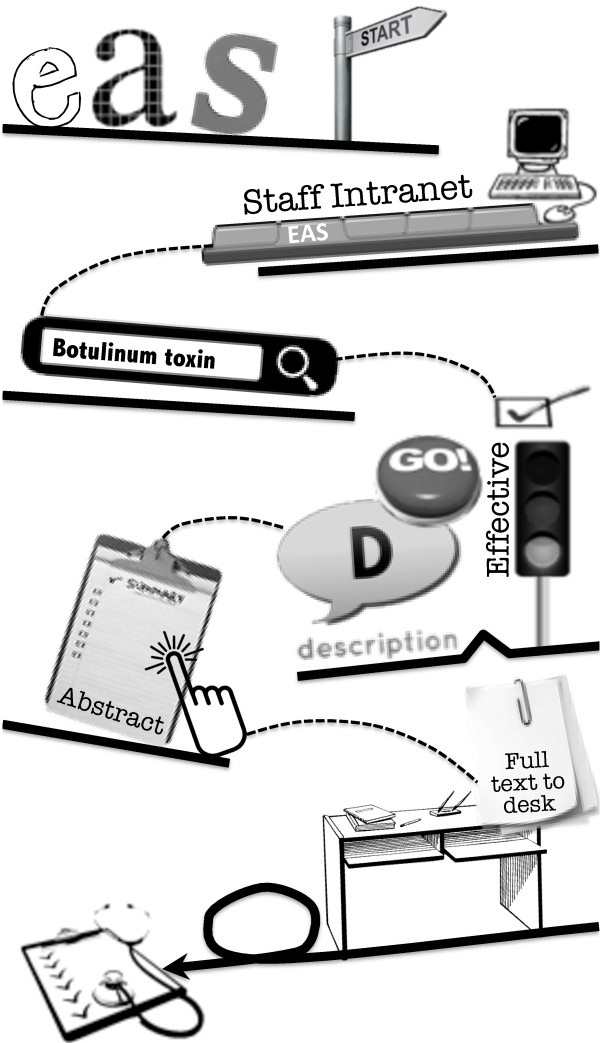
Evidence Alert System infogram.